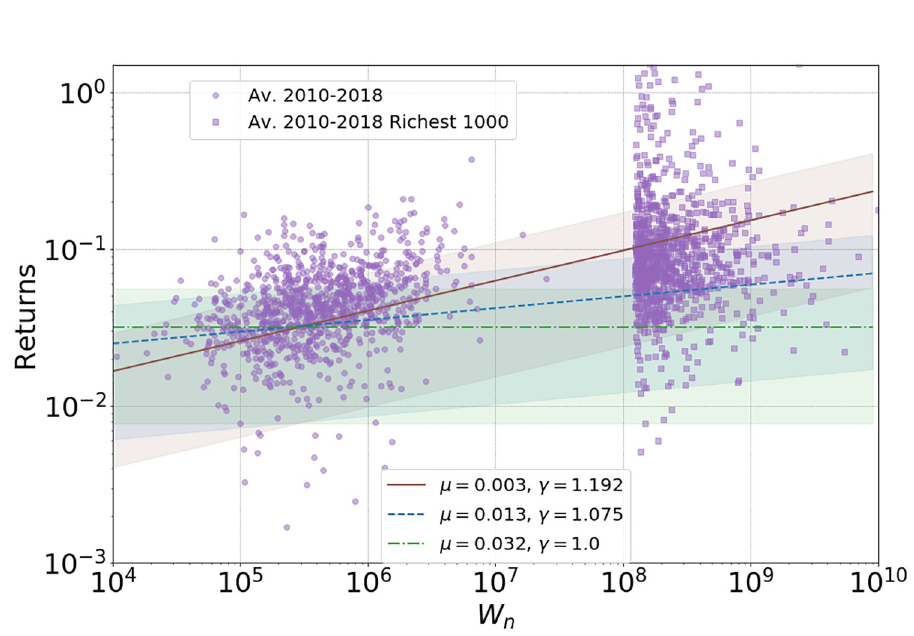
Fig 11. Average return over 2010–2018 for randomly chosen agents against agents wealth in 2018. The power fits (straight lines) for E ½ R j W � ¼ m W g (cid:0) 1 , are the three fits to the real world data from Fig 2, along with one standard n þ 1 n n deviation error